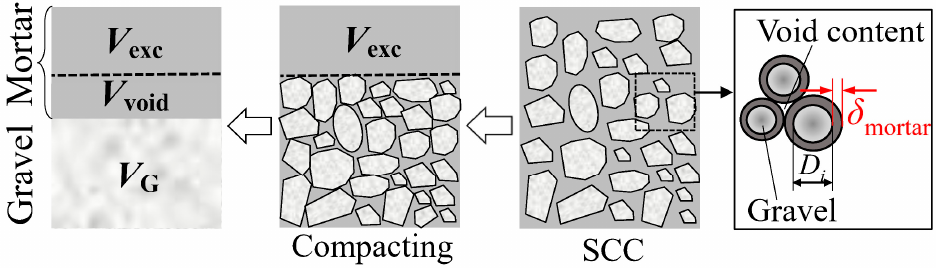
Figure 1. Schematic diagram of the mortar film thickness.